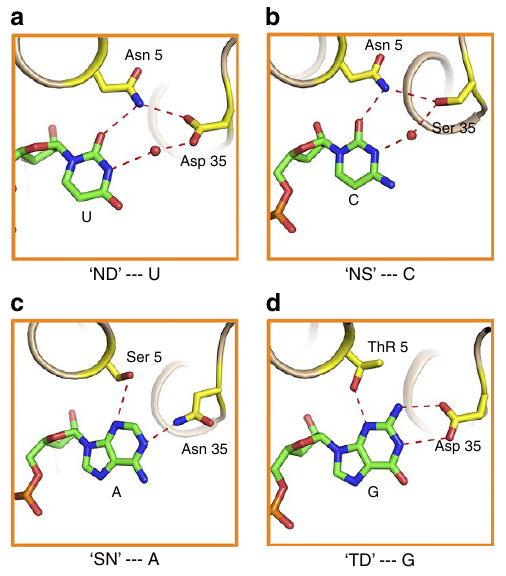
Figure 4 | Structural basis of nucleobase recognition by dPPR repeats. PPR code amino acids selectively target nucleotides by forming direct or indirect hydrogen bonds to the Watson–Crick faces of bases. The specific recognition patterns of the bases U ( a ), C ( b ), A ( c ) and G ( d ) by dPPR repeats are shown in the zoom-in view. The side chains of the 5th and 35th residues in each PPR repeat are shown in yellow. Bases are labelled and coloured according to atom type (carbon: green, oxygen: red, nitrogen: blue). The hydrogen bonds are represented by red dotted lines. Water molecules are represented by red spheres. Single-letter abbreviations for the amino acid residues and nucleobases are as follows: D, Asp; N,